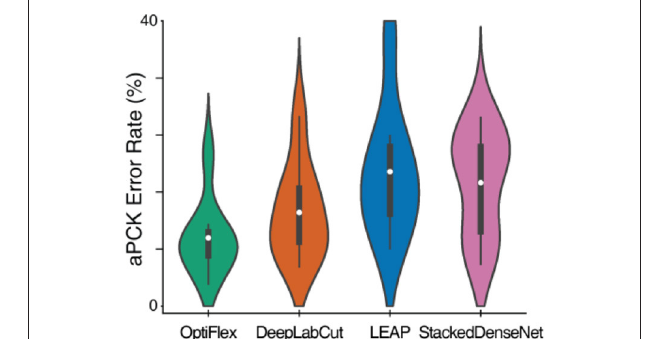
FIGURE 3 | Comparison of aPCK error rates of various frameworks on the mouse side-view dataset displayed as a violin plot. The white dots represent the mean; the dark grey boxes represent the range between 1st quartile and 3rd quartile; and the whiskers represent the variability outside the upper and lower quartiles. The violin plots are aggregations of key point prediction error rates of a given model on the mouse side-view test set (1,051 frames from different videos with 8 labelled key points). Each data point represents the aPCK error rate of a particular model’s prediction of a specific key point on the test set of mouse side-view